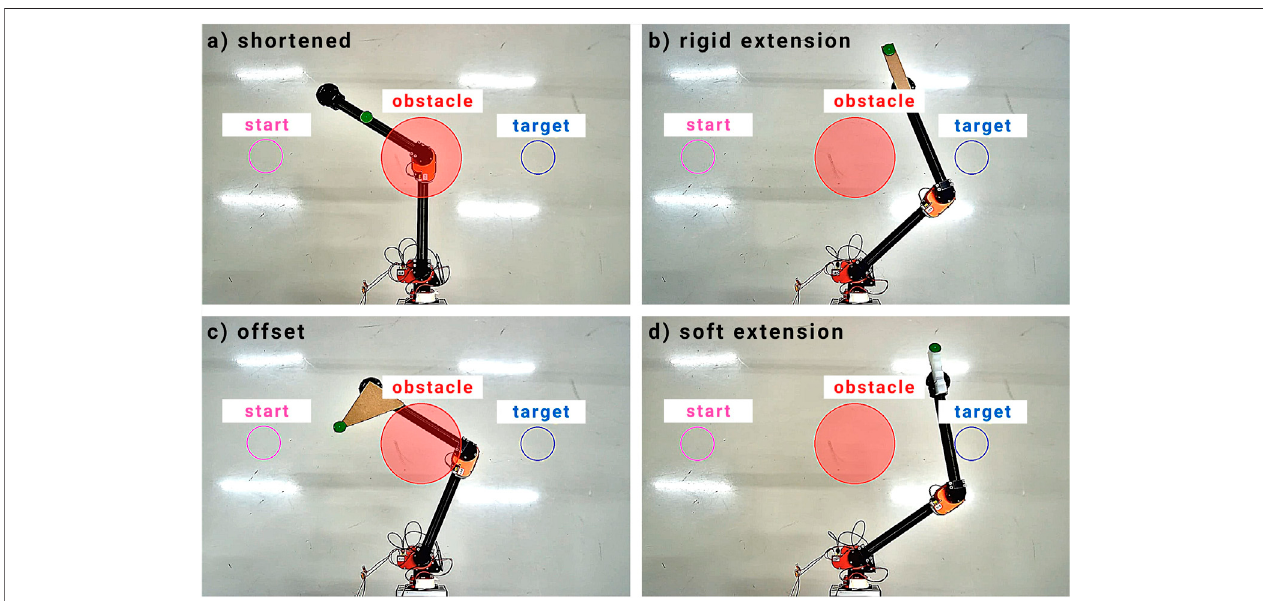
FIGURE1| Experimental setuptotest theadaptabilityoftheproposedKMF-PCcontroller.Themagenta circlerepresentstheinitialpointpriortorobotmotion, the red circle represents a virtual obstacle, and the blue circle represents the target position. The green circle on the robot is the tracked point. Midway reaching, the end effector is modi fi ed to demonstrate the adaptability of the controller. Four tests were conducted: (A) The end effector was shortened by moving the tracked point down thesecondlink; (B) Theendeffectorwaslengthenbyaddingarigidextension; (C) Theendeffectorwasoffsetatanangle; (D) Theendeffectorwasextendedusing a soft